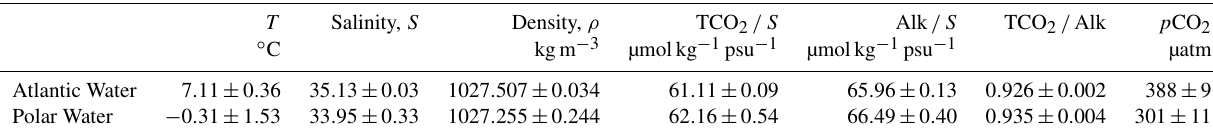
Table 2. Mean IRM-TS Atlantic Water surface layer conditions in winter in 2001–2010 and in the Polar Water 25m surface layer from November to April